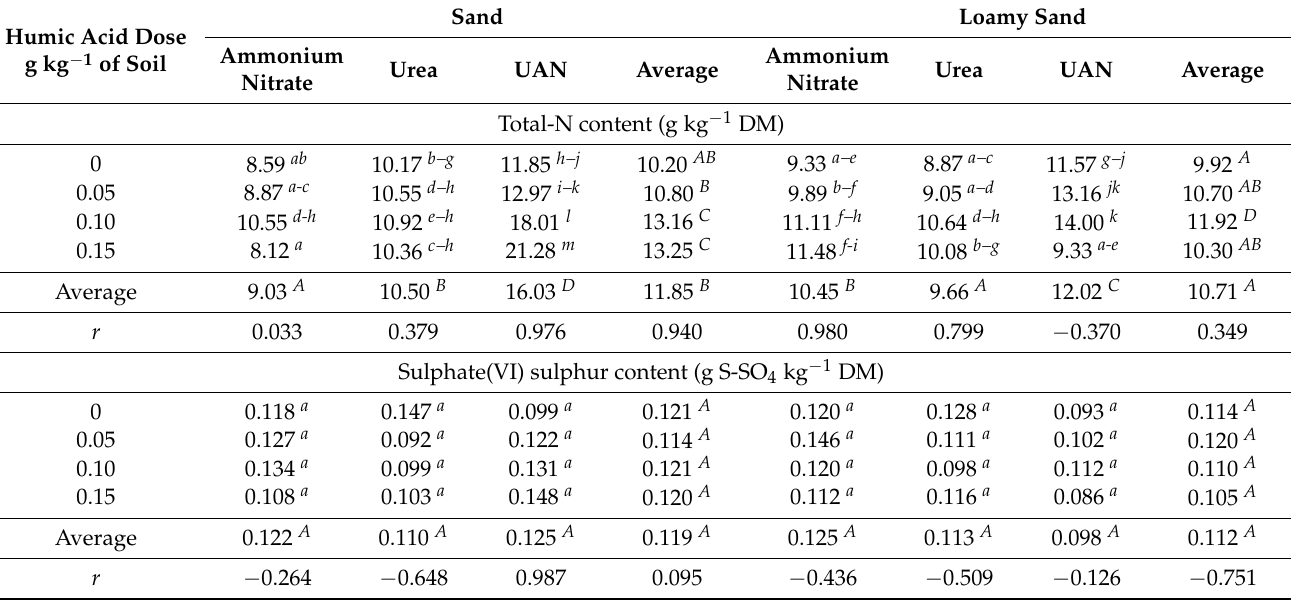
Table 2. Content of total-N and sulphate sulphur (VI) in maize— Zea mays L. (g kg − 1